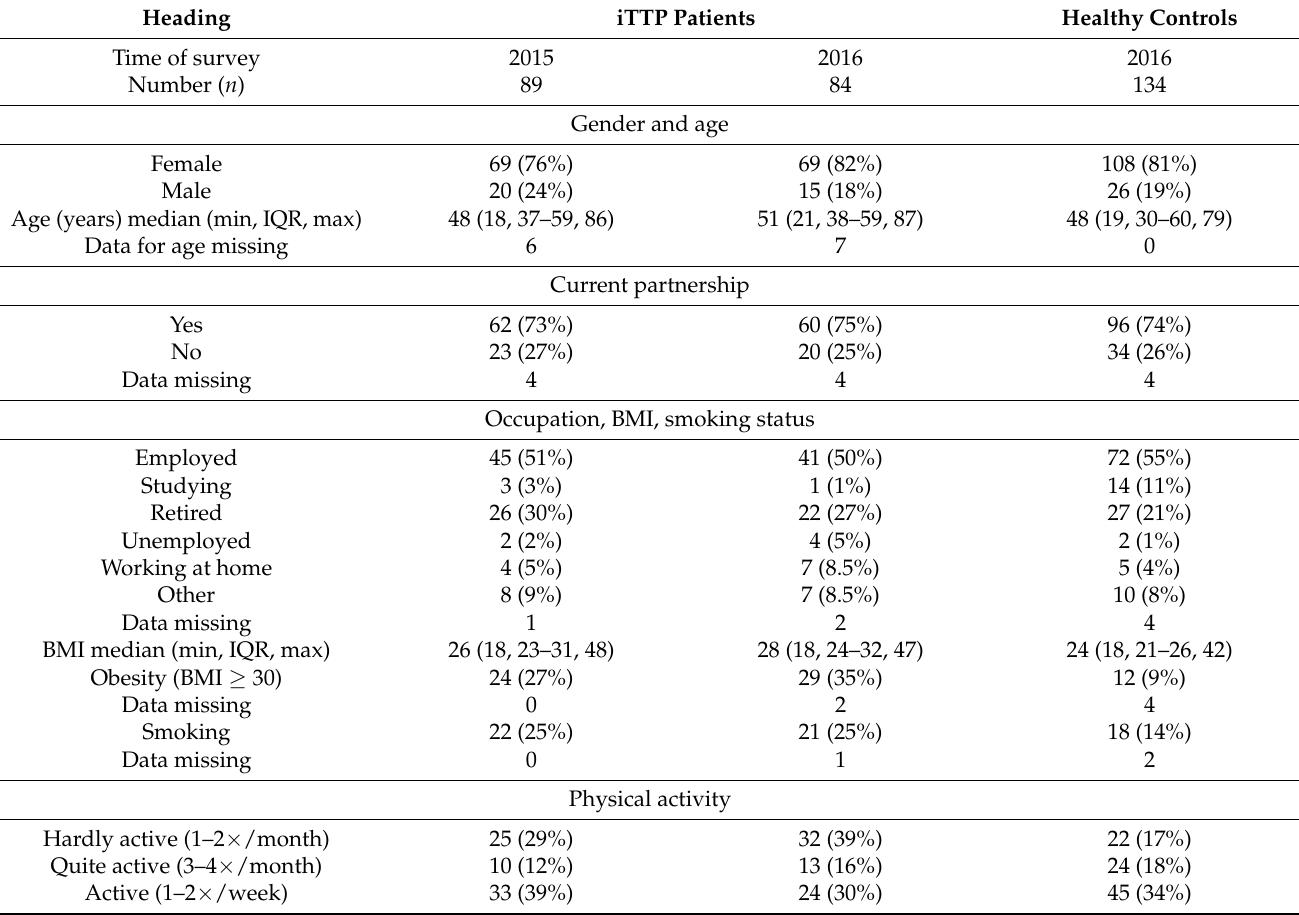
Table 1. Characteristics of the responding and evaluable autoimmune thrombotic thrombocytopenic purpura (iTTP) patients in both surveys and of the healthy